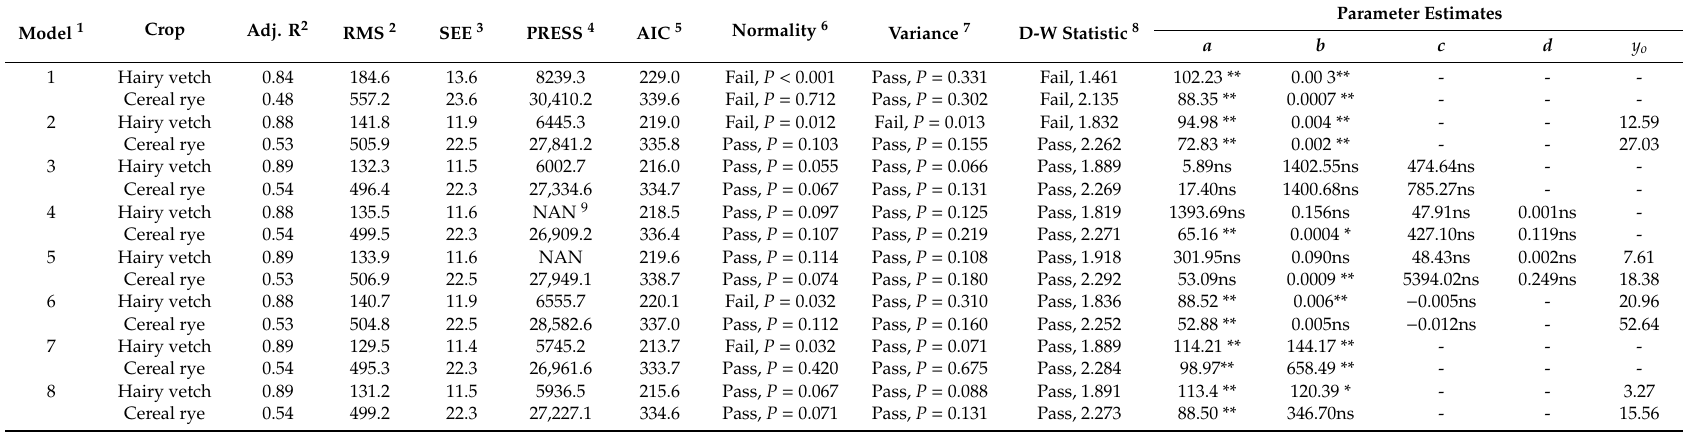
Table 6. Evaluation of models used to describe percent N remaining of belowground biomass of hairy vetch and cereal rye cover crops at Exp. 1 in 2015. Data were from no-till plots at Carbondale,